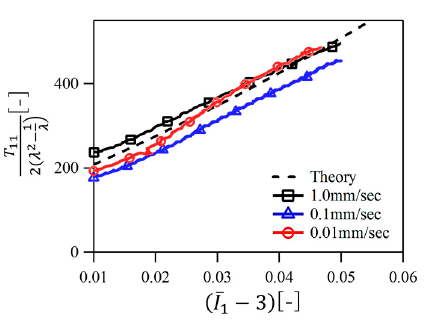
Figure 7. Relationship between (𝐼̅ (cid:2869) − 3) and (cid:3021) (cid:3117)(cid:3117)